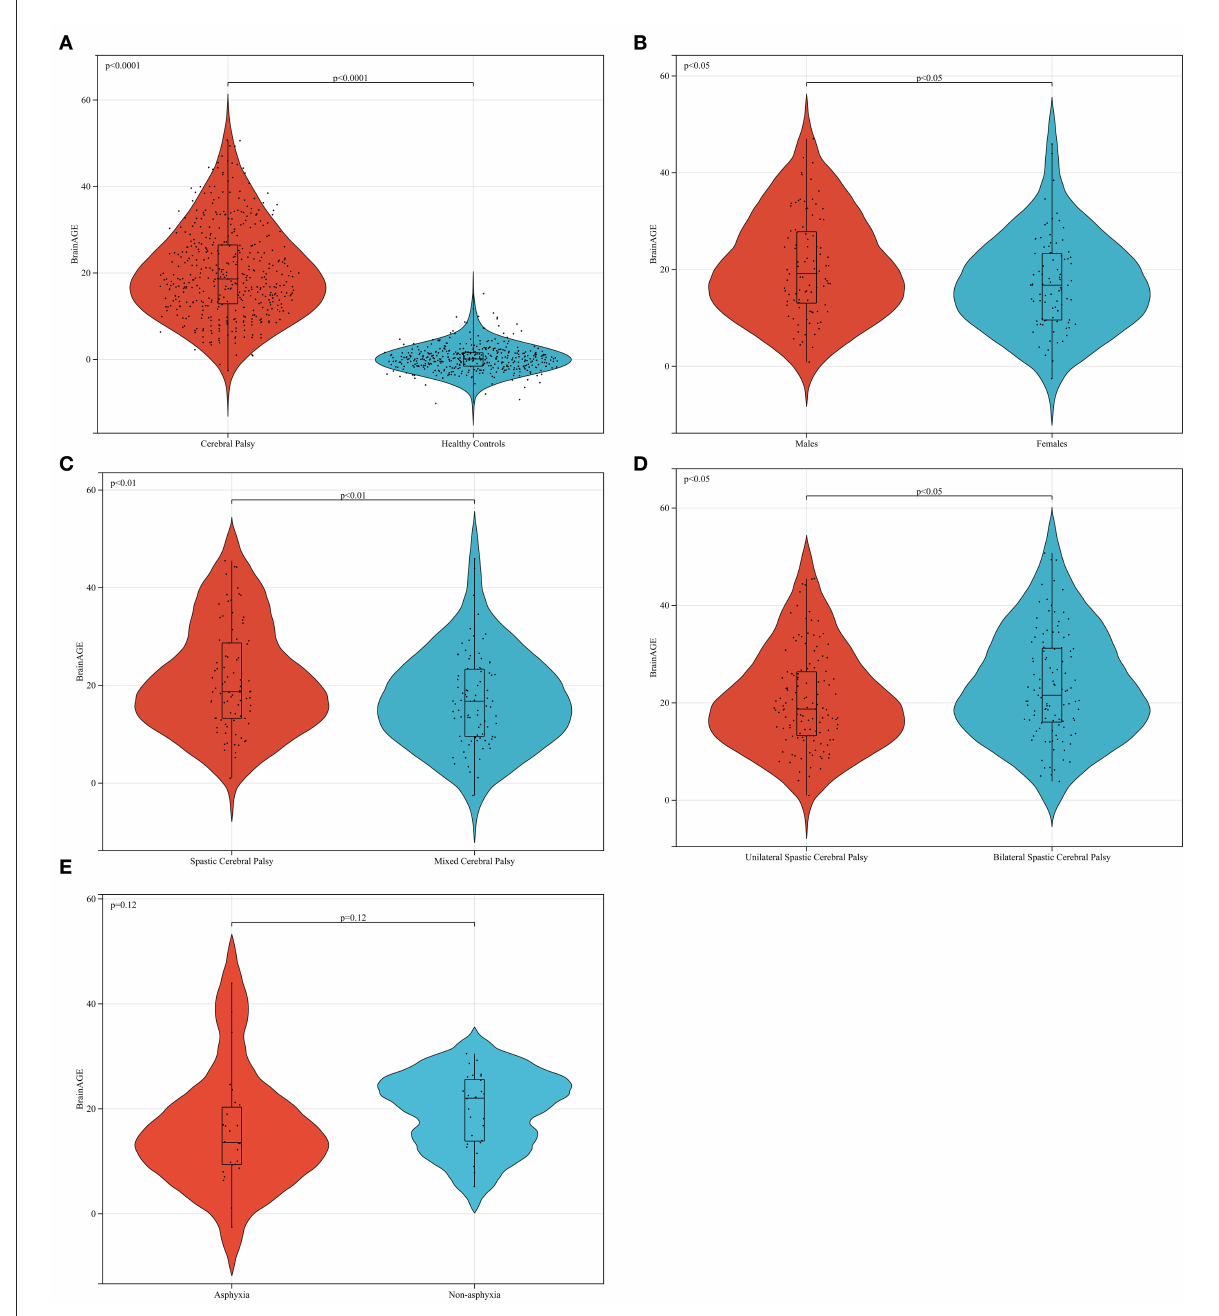
FIGURE7 Data analysis of brain age difference in patients with cerebral palsy. In (A) the BrainAGE of patients with CP is higher than that of healthy peers ( p < 0.0001). In (B) the brain age difference of men is higher than that of women in patients with mixed cerebral palsy ( p < 0.05). In (C) the brain age difference of female patients with spastic CP was higher than that of patients with mixed CP ( p < 0.01). Furthermore, the BrainAGE of patients with bilateral spastic CP was higher than that of patients with unilateral spastic cerebral palsy ( p < 0.05), as shown in (D) . In (E) the BrainAGE of patients with non-asphyxia was higher than that of patients with asphyxia in female mixed CP ( p = 0.12).